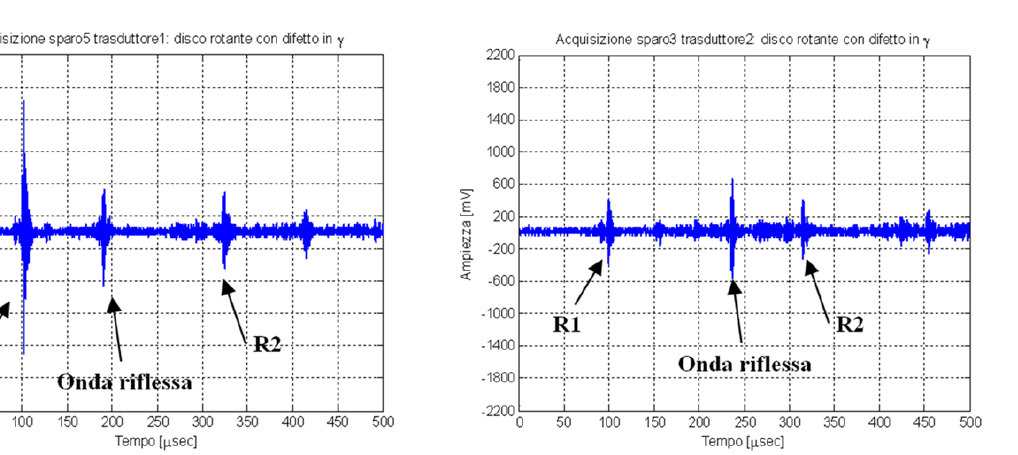
Figura 7: Segnale acquisito dal trasduttore 2. Disco rotante con difetto in γ =-70°. Figure 7: Signal acquired by transducer 2. Rotating disk with defect at γ =-70°.